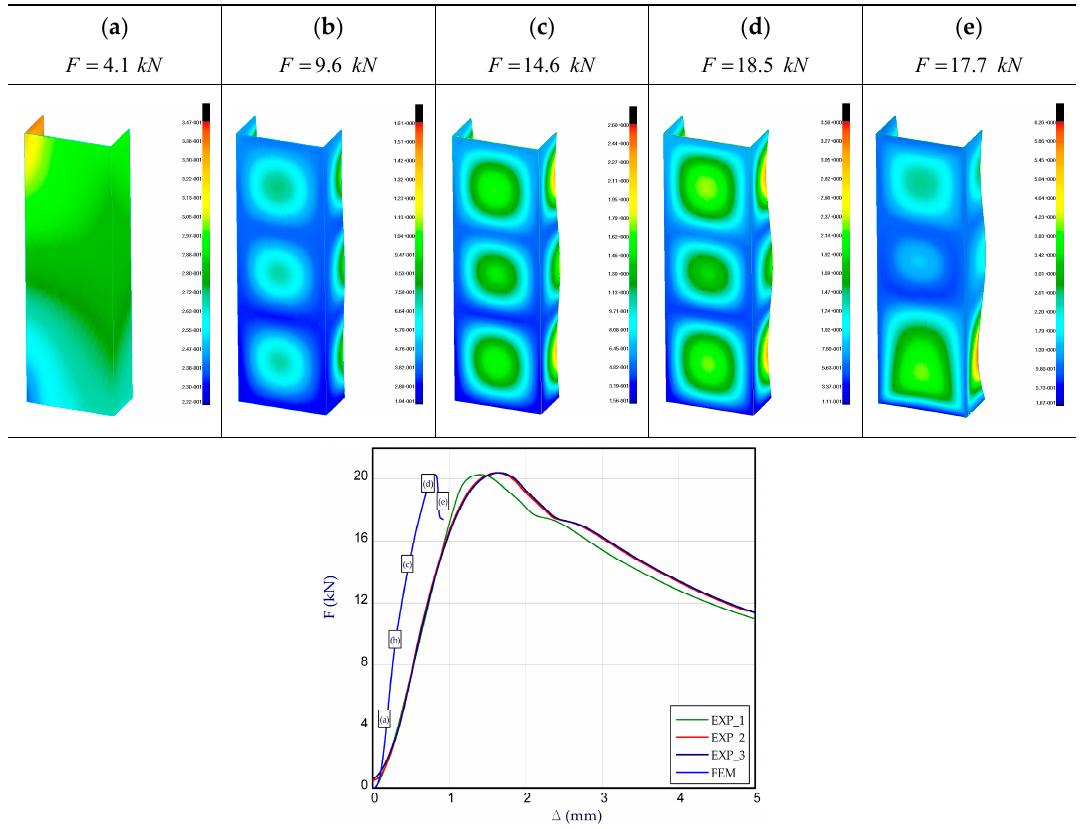
Figure 7. The compression curve (force vs. shortening) of column with deformation maps of column: ( a – e ).